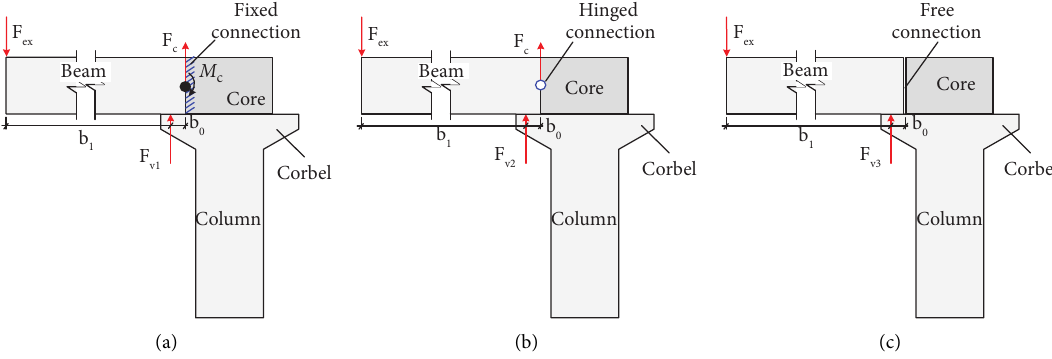
Figure 14: Simplified calculation model: (a) fixed connection, (b) hinged connection, and (c) free